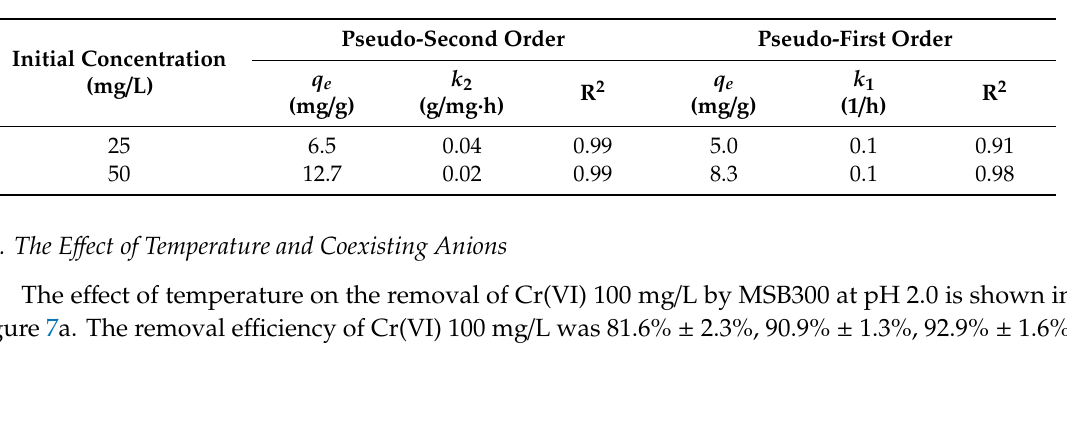
Figure 6. The concentrations variation of Cr(VI), Cr(III), and total Cr by MSB300 with initial concentration of Cr(VI) of 25 mg / L ( a ) and 50mg / L ( b ) at pH 2.0. The redox potential (Eh) variation during Cr(VI) removal by MSB300 ( c ). Table 4. The parameters of pseudo-first-order and pseudo-second-order ( k 1 and k 2 are the rate constants for the pseudo-first-order and pseudo-second-order).